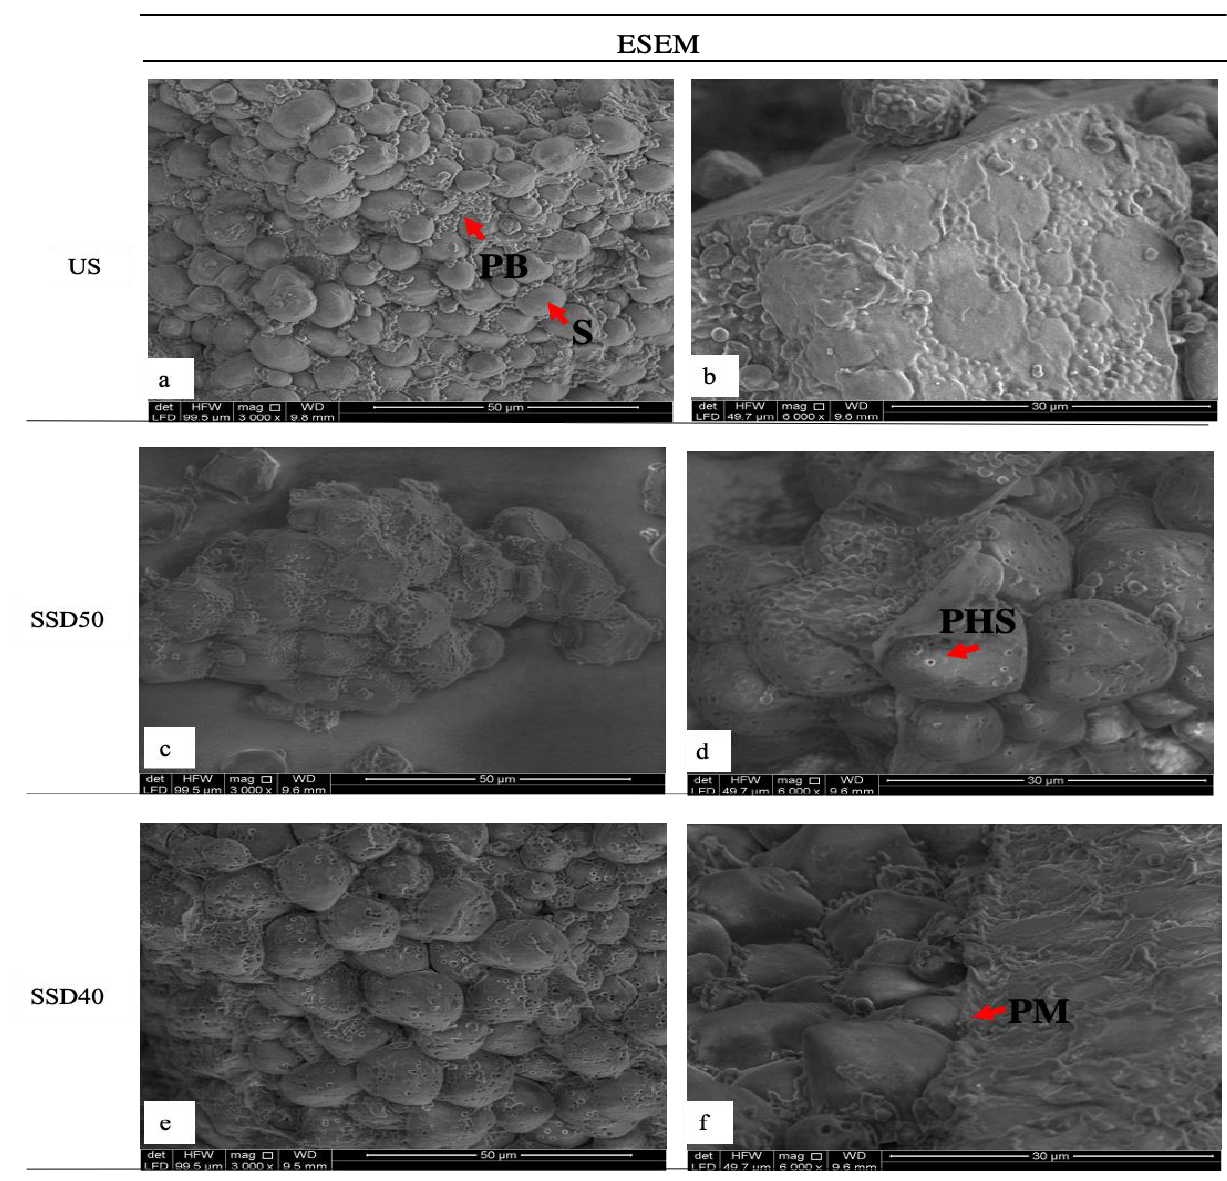
Figure 4. Morphological observations of sorghum flours acquired with environmental scanning electron microscopy (ESEM). Micrographs of US, SSD50 and SSD40 flours were acquired with a magnification of 3000 × ( a , c , e ) and 6000 × ( b , d , f ). US, unsprouted sorghum flour; SSD50, flour from sprouted sorghum dried at 50 ◦ C for 6 h; SSD40, flour from sprouted sorghum dried at 40 ◦ C for 12 h; S, starch granule; PB, protein body; PHS, partially hydrolyzed starch; PM, protein